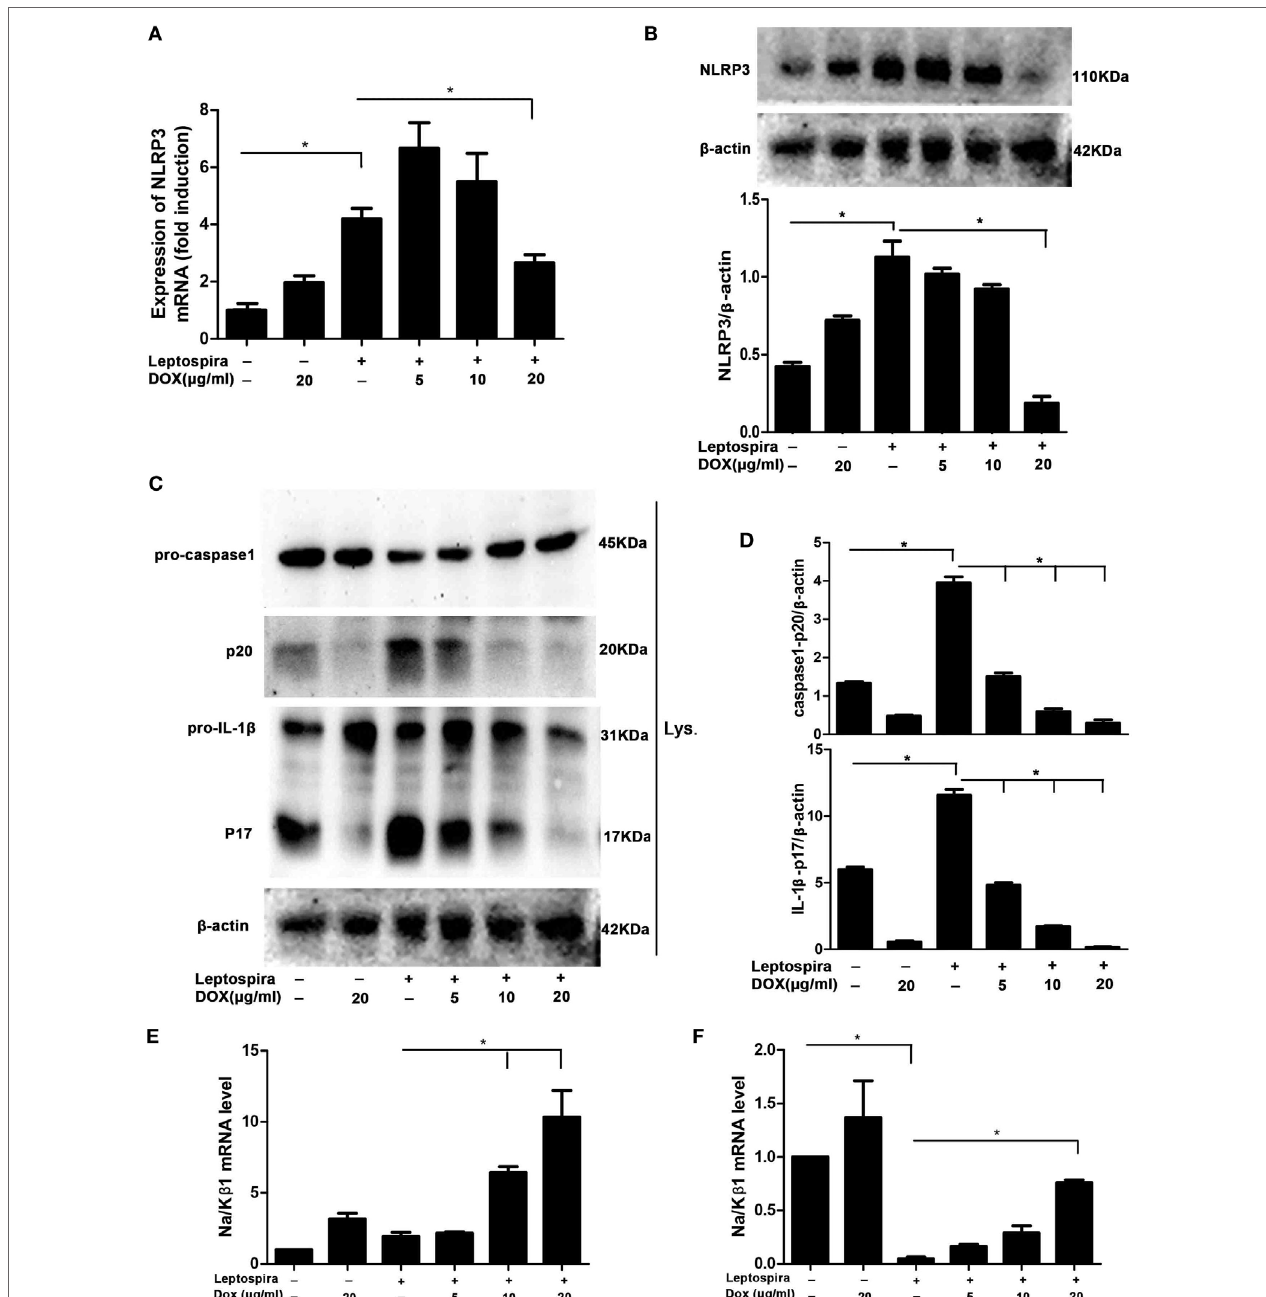
FigUre 4 | Doxycycline suppressed NLRP3 inflammasome priming with upregulation of the expression of the Na/K β 1 subunit during leptospira infection. The expression of NLRP3 mRNA (a) in sonicated leptospira-infected J774A.1 cells was analyzed by quantitative real-time polymerase chain reaction (qRT-PCR). The mRNA levels of NLRP3 in J774A.1 cells were normalized to the expression of the housekeeping gene GAPDH. The expression of NLRP3 protein (B) , the activation of caspase-1, and the release of mature IL-1 β in cell extracts (Lysate) (c,D) were analyzed by western blot. The β -Actin protein was used as a control. The expression of Na/K β 1 subunit mRNA was analyzed by qRT-PCR in sonicated (e) and live (F) leptospira-infected J774A.1 cells. The mRNA levels of Na/K β 1 subunit in J774A.1 cells were normalized to the expression of the housekeeping gene GAPDH. All bars show the mean ± SD of three independent experiments and analyzed by the one-way ANOVA. * p <